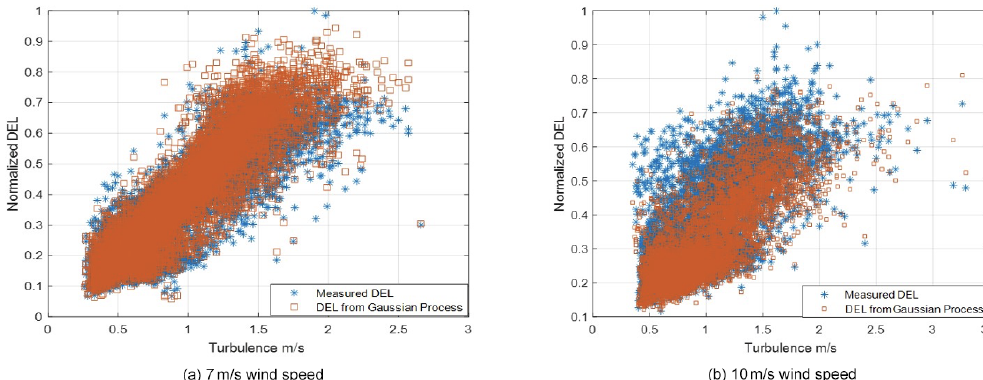
Figure 8. Comparison of the 10min blade root flap bending damage equivalent moments between the Gaussian process method and mea- surement data on the C-08